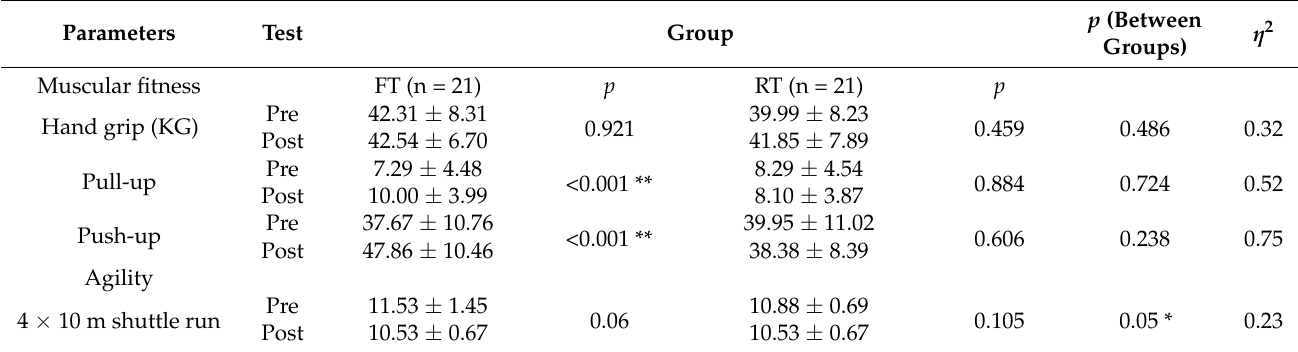
Table 4. Athletic performance data from FT and RT